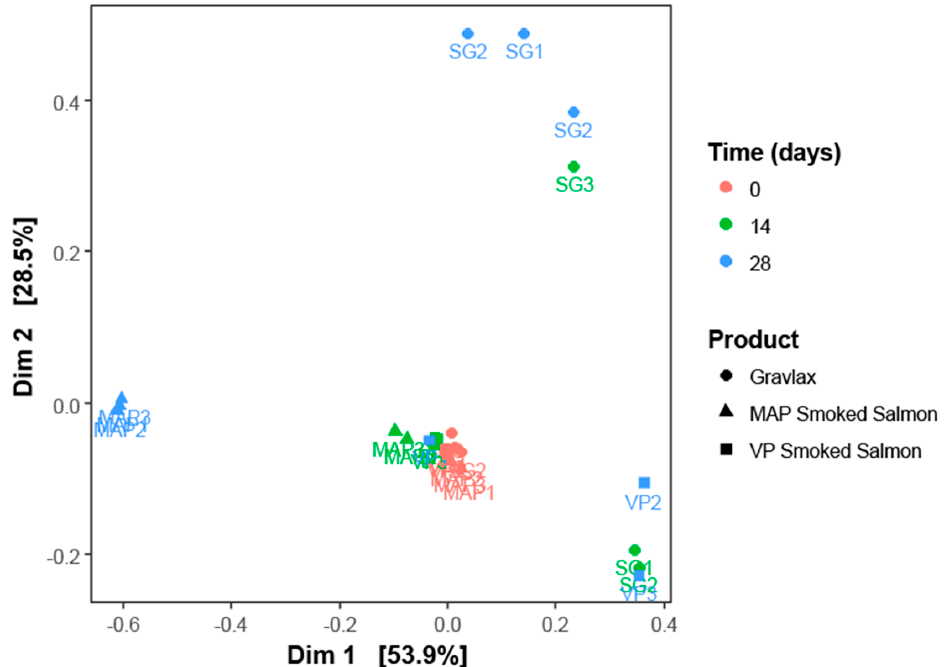
Figure 3. Multidimentional scaling representation of the SG, MAP and VP CSS samples microbial composition based on Bray–Curtis distances. The sample nomenclature is structured as follows: (1) the type of product (SG, MAP or VP) and (2) the replicate number.